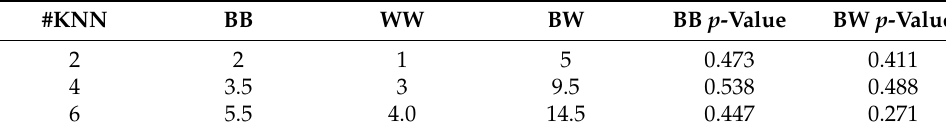
Table 7. Joint count statistics for spatial autocorrelation in Pakistan.